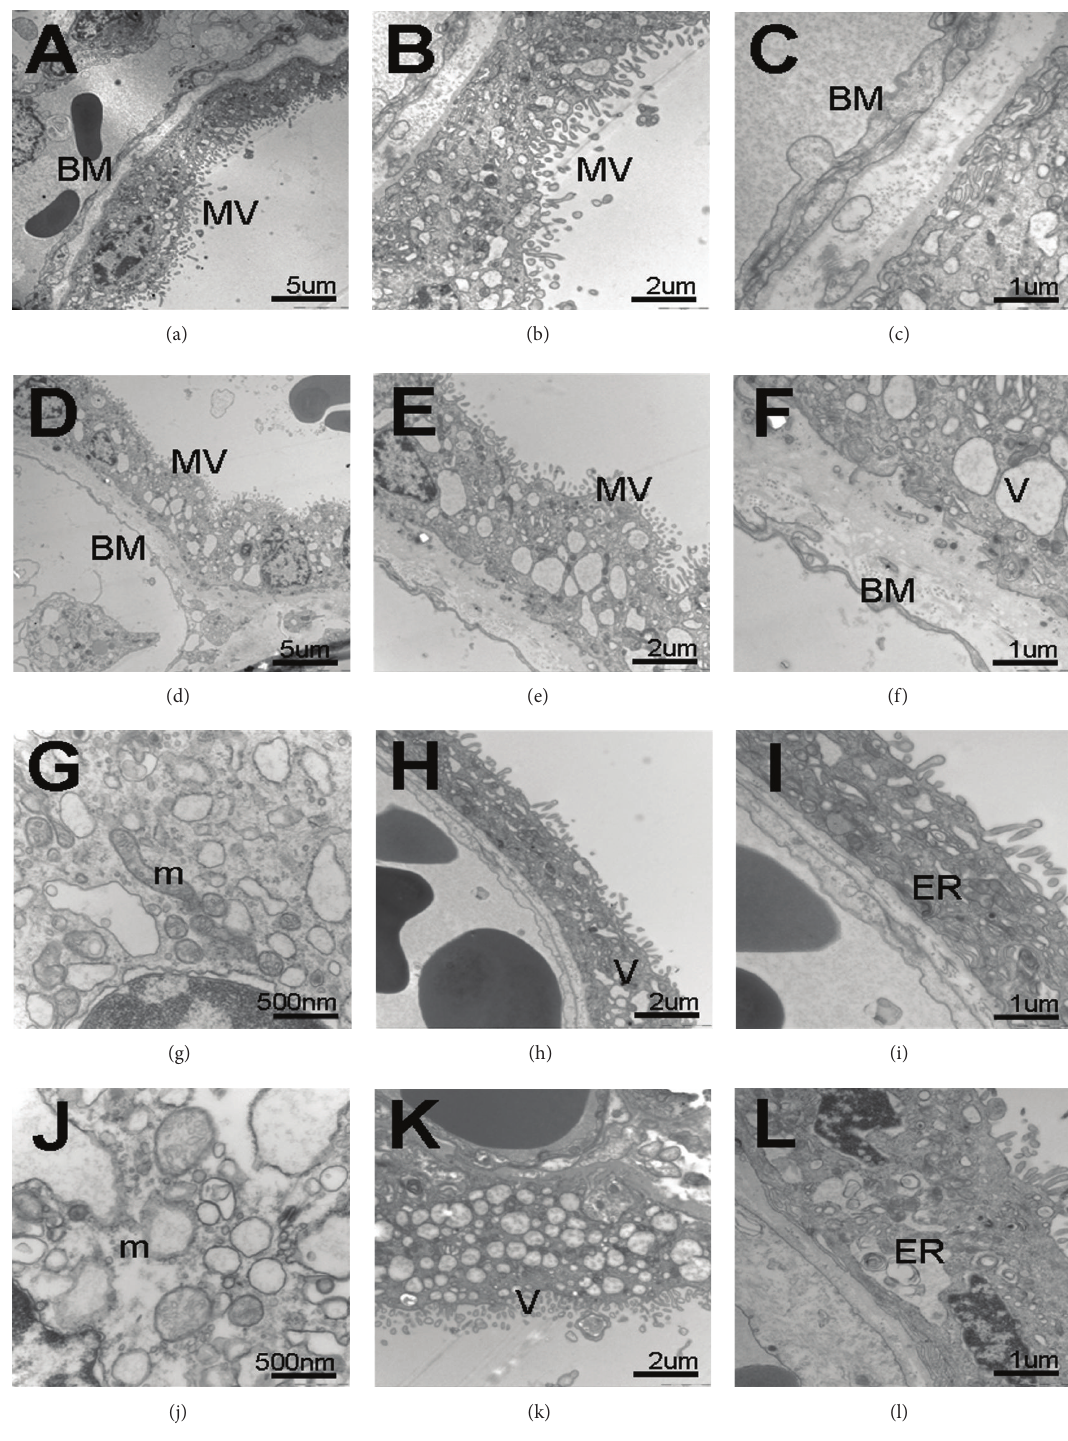
Figure2:Ultrastructureofplacentasfromcontrolgroup(a–c,g–i)andGDMgroup(d–f,j–l)observedusingaJEM-1010electronmicroscope. TEM images showed at different magnifications ( × 5000 (a and d), × 12 000 (b and e), and × 25 000 (c and f)). (a–c) Normal placental barriers were displayed in control, VSM, composed of the outer layer ST with a multitude of microvilli (MV) on the surface, fetal capillaries with fetal bloodcellsinside,andBMandinterspacesbetweenthem.(d–f)InGDMgroup,intactplacentalbarrierswereapparentalongwithdegenerative alterations of the terminal villi, mainly in VSM and BM, including thicker placental barriers, decreased apical microvilli, and increased multiple vacuoles (V) in ST. Bar = 5um (a and d), 2 um (b and e), and 1um (c and f). (g–i) Mitochondria (g), cytoplasmic vacuoles (h), and ER (i) with normal appearance in the cytoplasm of ST in control group. (j) The massive swelling, even ridge deprivation, and architectural disruption of mitochondria (m) in the GDM placenta. (k) The massive cytoplasmic vacuoles accumulation in the ST of GDM placenta. (l) The dilation of endoplasmic reticulum (ER) cisternae in GDM group. Bar = 500 nm (g and j), 2um (h and k), and 1 um (i and